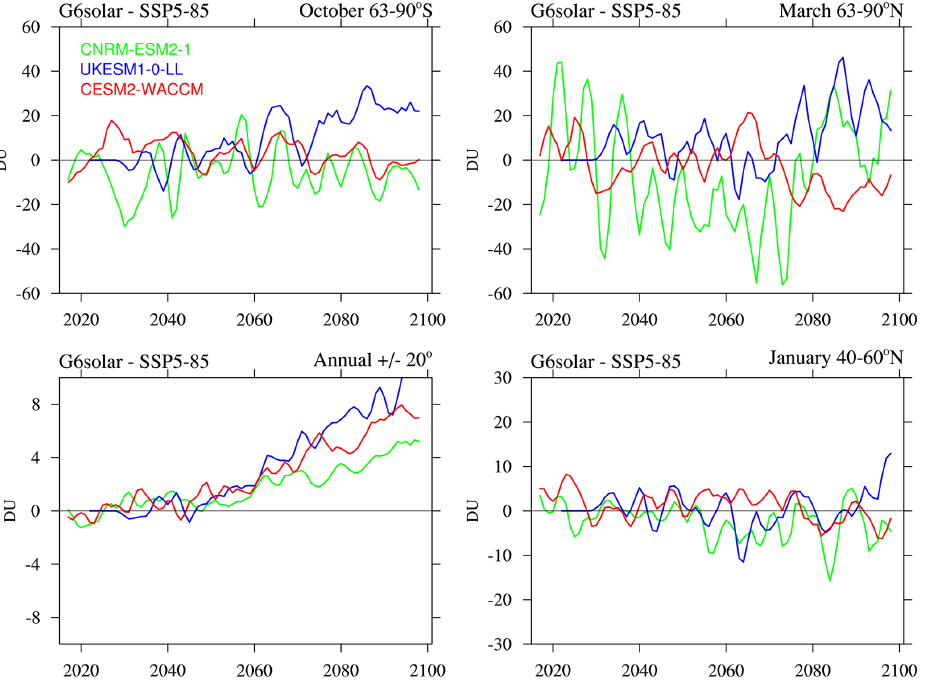
Figure 10. Differences between G6solar and SSP5-8.5 for the ensemble mean of total column ozone between 2020 and 2100 for the three different models (colored lines) and for four different seasons and regions (different